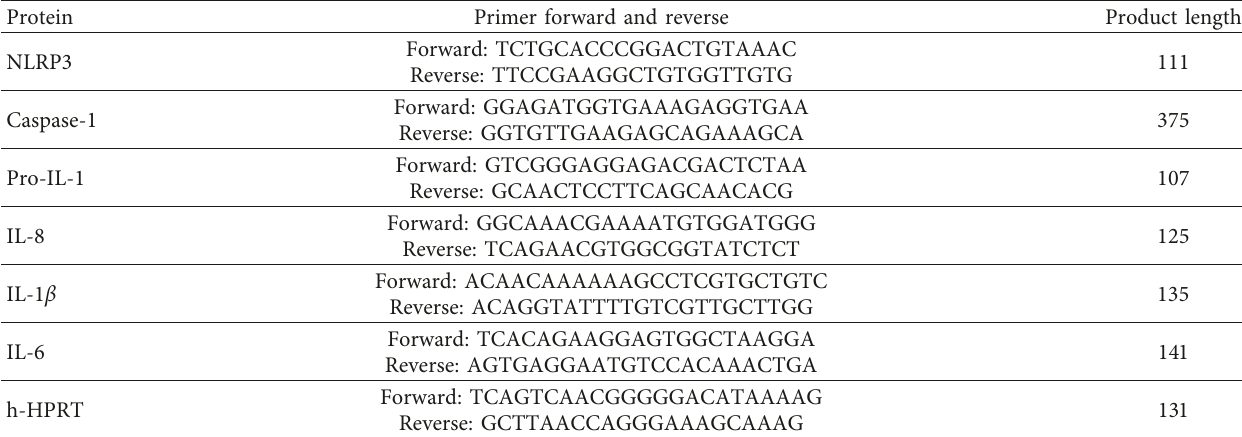
Table 1: Designed primers for inflammation